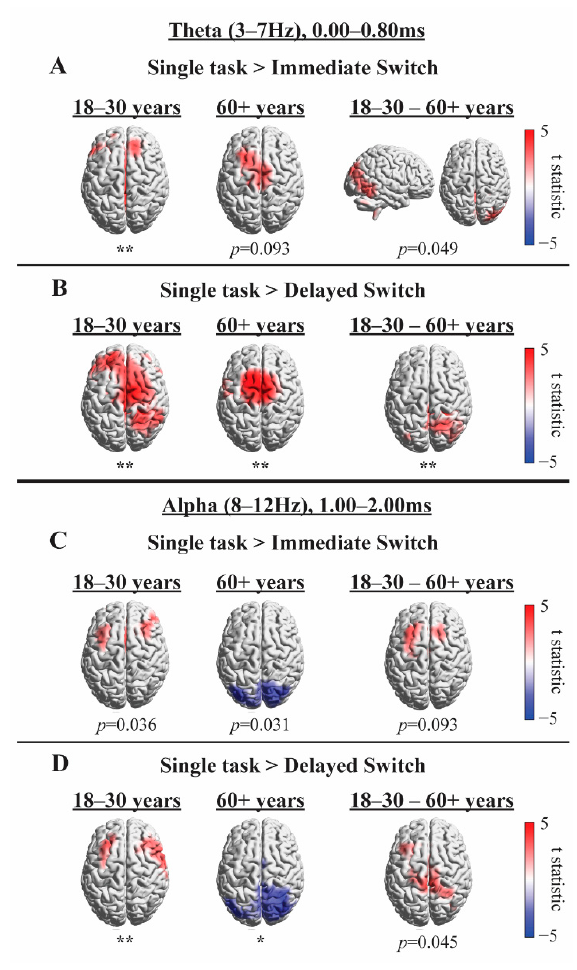
Figure 5. eLORETA source solutions for each age group (left and middle column) and for between-group comparisons (right column). Panels A and B depict solutions for theta (3–7 Hz; 0.00–0.80 s) and Panels C and D for alpha (8–12 Hz; 1.0–2.0 s), each for a time period after the onset of the road sign. Panels A and C show results for the Immediate Switch condition and Panels B and D for the Delayed Switch condition; both in relation to the Single-Task condition. Cluster significance levels from a two-tailed test are indicated as * p < 0.025, ** p < 0.01.